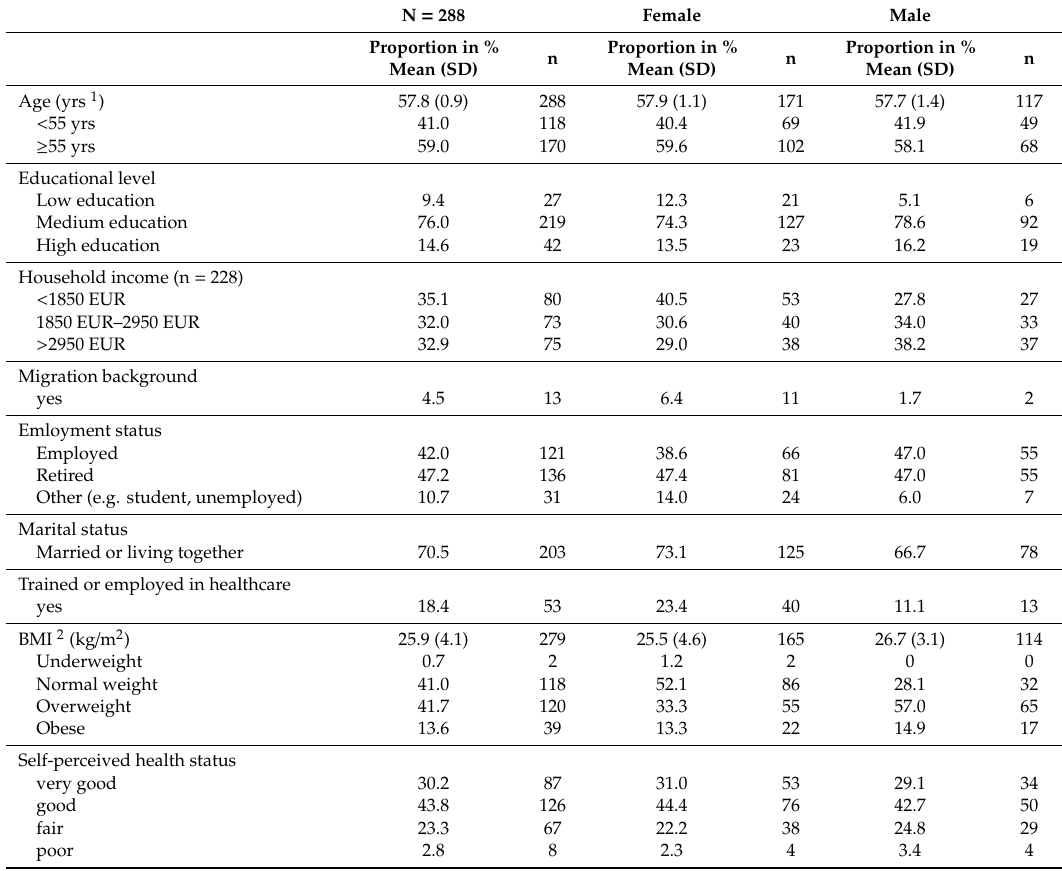
Table 1. Baseline characteristics of the study population.